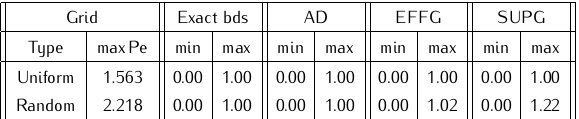
Table 1. Violation of the global solution bounds for the horizontal advection problem with ε 33 × 33 uniform and randomly perturbed